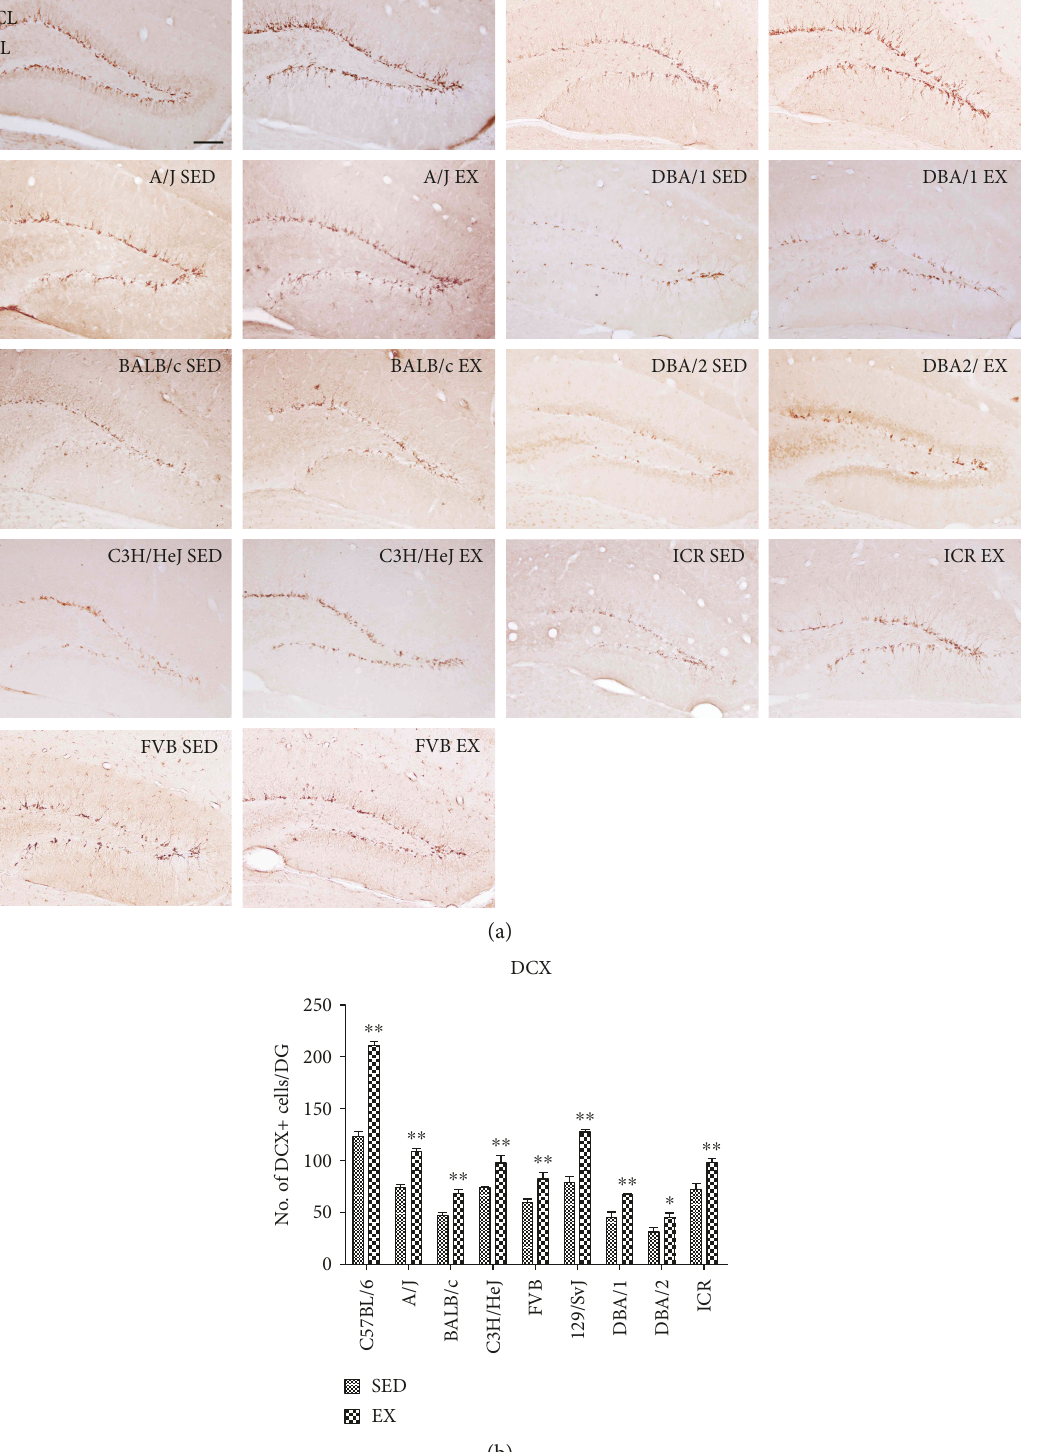
Figure 4: Immunohistochemistry for doublecortin (DCX) in the dentate gyrus of sedentary and exercise mice of 9 di ff erent strains (a). GCL, granule cell layer; ML, molecular layer; PoL, polymorphic layer. Scale bar =100 μ m. Quantitative analysis of DCX-immunoreactive neuroblasts per section in sedentary and exercise mice (b) ( n = 5 per group); ∗ indicates a signi fi cant di ff erence between the sedentary and exercise groups ( p < 0 05 ), and ∗∗ indicates a signi fi cant di ff erence between the sedentary and exercised groups ( p < 0 01 ). Data are shown as mean ±